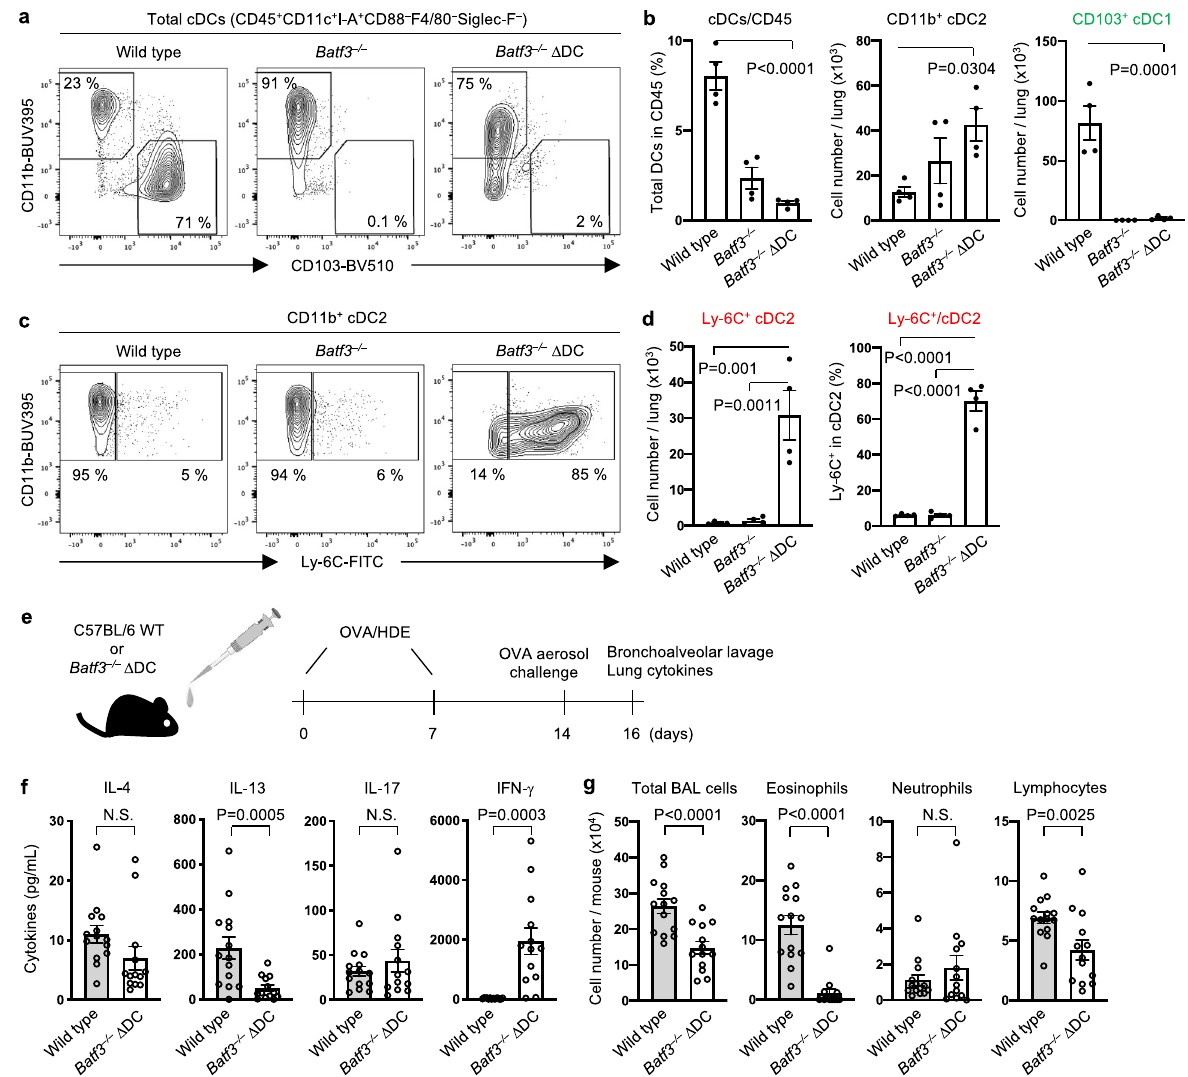
Fig. 4 Ly-6C + cDC2 are suf fi cient for induction of Th17-dependent neutrophilic airway in fl ammation. a – d Analysis of cDCs (CD45 + CD11c + I-A + CD88 – F4/ 80 – Siglec-F – Live/Dead – ) in the lungs of WT C57BL/6, C57BL/6- Batf3 – / – and C57BL/6- Batf3 – / – Δ DC mice at steady state, including representative cytograms ( a , c ), and compiled data ( b , d ) showing percentages and cell numbers for total cDC, cDC2, and cDC1 ( b ), and for Ly-6C + cDC2 ( d ). The gating strategy is shown in Supplementary Fig. 1d. Data were analyzed by ordinary one-way ANOVA with Dunnett ’ s multiple comparison test ( n = 4). Data are presented as mean±SEM. e Timeline for allergic sensitization and allergen challenge in HDE/OVA-mediated mouse model of asthma. f Cytokine production in lungs of challenged mice, as measured by ELISA. g Cell numbers for the indicated leukocyte subsets in BALF of allergen-challenged WT and Batf3 – / – Δ DC mice. Data were analyzed by ordinary one-way ANOVA with Tukey ’ s multiple comparison test ( n = 14 WT and n = 13 Batf3 – / – Δ DC mice). Data are presented as mean±SEM. Combined results of two independent experiments are shown. Source data are provided as a Source Data fi